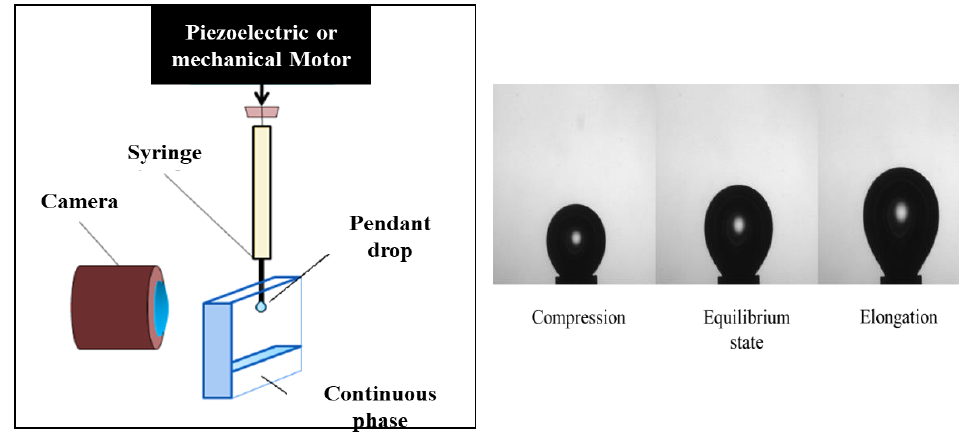
Figure 22. Close-up views of an oscillating drop.